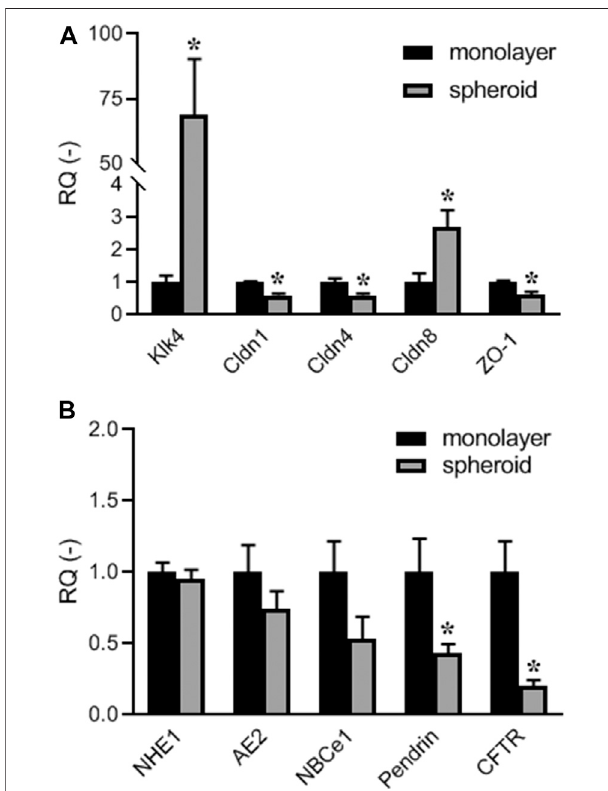
FIGURE 4 | Quantitative RT-PCR data showing expression of: (A) maturation-phase ameloblast marker Klk4, and tight-junction protein genes Cldn1, Cldn4, Cldn8 (claudins 1, 4, and 8), and Tjp1 (ZO-1); (B) electrolyte transporter genes Slc9a1 (NHE1), Slc4a2 (AE2), Slc4a4 (NBCe1), Slc26a4 (pendrin), and Cftr (CFTR). Expression levels in HAT-7 cells grown in Matrigelwith Hepato-STIM medium (spheroid) were normalised to expression levels in HAT-7 cells grown on Transwell permeable supports in differentiation medium (monolayer). Data are mean ± SEM. * p < 0.05 (n (cid:2)